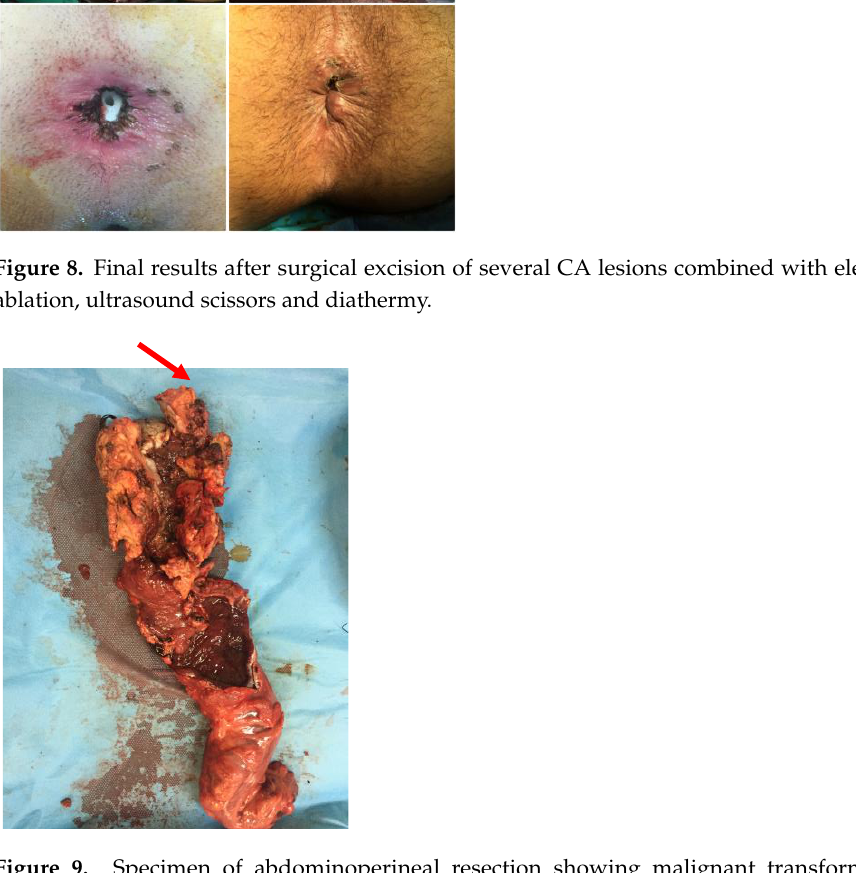
Figure 8. Final results after surgical excision of several CA lesions combined with electrocautery ablation, ultrasound scissors and diathermy.